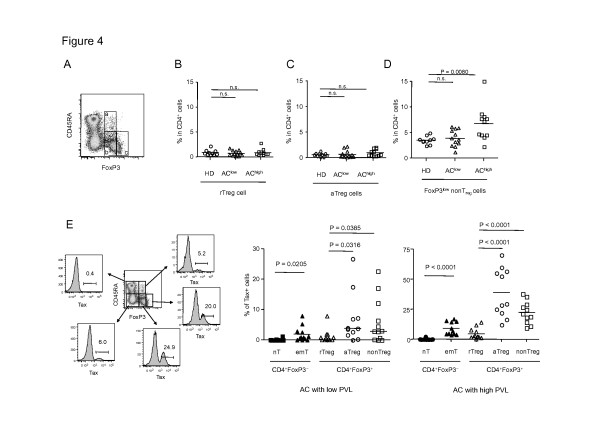
Characterization of FoxP3+CD4+T-cell subset in AC samples. (A) A result of flow cytometric dot plots of CD45RA and FoxP3 in CD4+ T cells of an AC sample is shown as an example. FoxP3+CD4+ T cells were classified into three subsets. a, CD45RA+FoxP3low resting Treg cells (rTreg cells); b, CD45RA−FoxP3low non-regulatory T cells (FoxP3low non-Treg cells), c, CD45RA−FoxP3high activated Treg cells (aTreg cells). (B–D) Frequencies of the FoxP3+CD4+ T-cell subset in HD, AClow, and AChigh. Percentages of resting Treg cells (B), activated Treg cells (C), and FoxP3low non-Treg cells (D) in CD4+ T cells are shown. (E) Representative flow cytometric dot plots of CD45RA and FoxP3 and histograms of Tax expression in each CD4+ T-cell subset in an AC sample (Left panel). Cumulative results from 13 AClow and 10 AChigh individuals are shown in the graph (Middle and right panels).